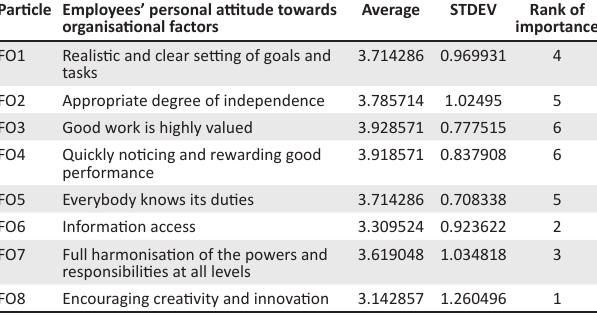
TABLE 9: Importance of organisational climate factors to employees. Particle Employees’ personal attitude towards organisational factors